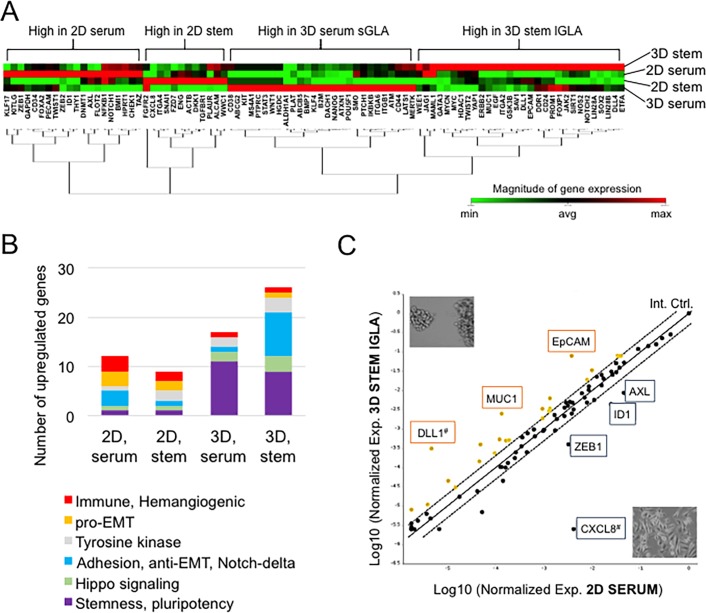
Gene expression profiling of CSC markers in the 2D and 3D culture nanoenvironments.PC-3 cells were cultured in four different conditions designated: 2D, serum; 2D, stem; 3D, serum; 3D, stem conditions. (A) Clustergram and dendrogram analysis of stem-cell-related genes. (B) Building block analysis of stem-cell-related genes. (C) Scatter plot analysis. Genes were plotted according to the mRNA expression levels in the 3D stem-cell condition (ordinate) and the 2D serum-containing condition (abscissa). #These gene’s average threshold cycle is relatively high (> 30) in any sample, and is reasonably low in the other sample (< 30).